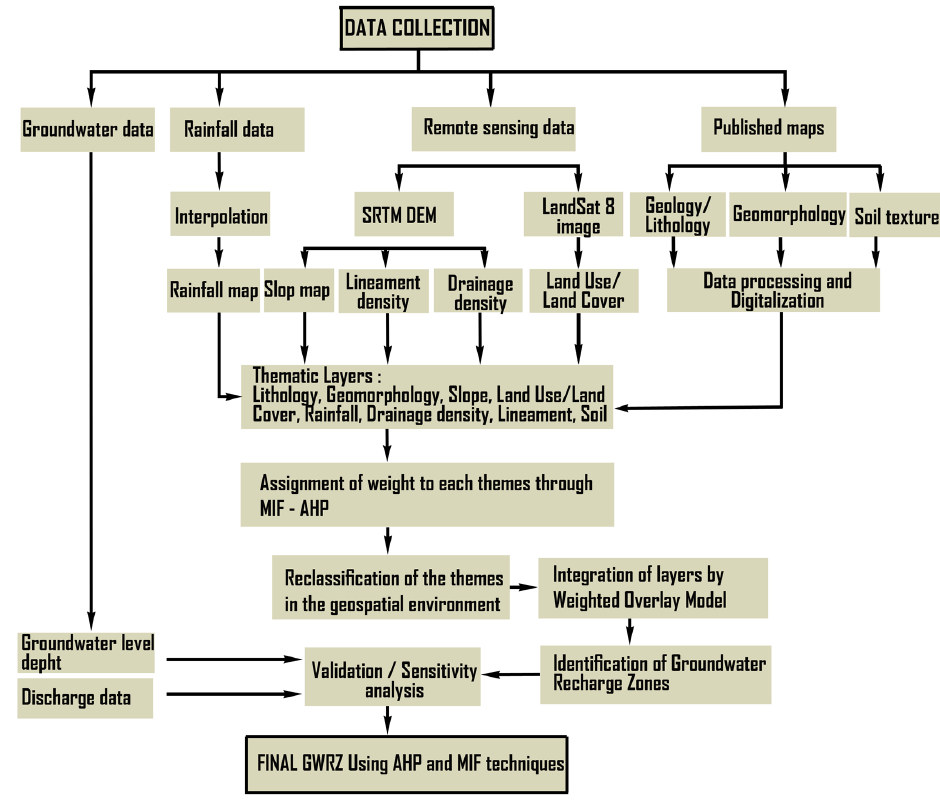
Figure 4. Framework to delineate groundwater recharge zones.